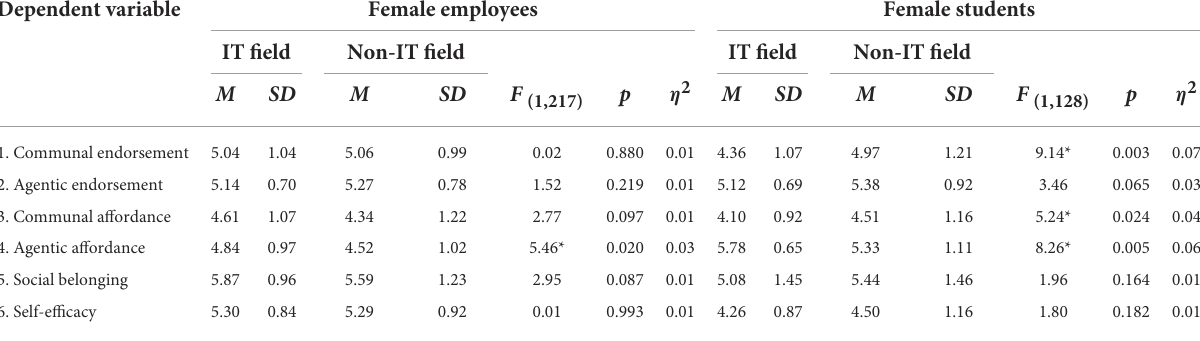
TABLE 2 Results of a series of MANOVAs showing differences between female employees and students in IT vs. non-IT fields. Dependent variable